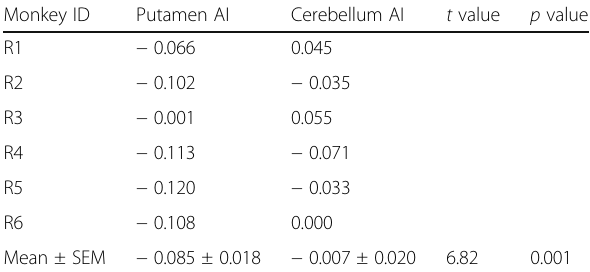
Table 2 Asymmetry index (AI) results for monkeys with allogeneic iPSC-mDA. Putamen asymmetry is detected due to the unilateral placement of allogeneic grafts, while no asymmetry is noticed in the cerebellum. AI between the putamen and cerebellum were compared using a paired t test Monkey